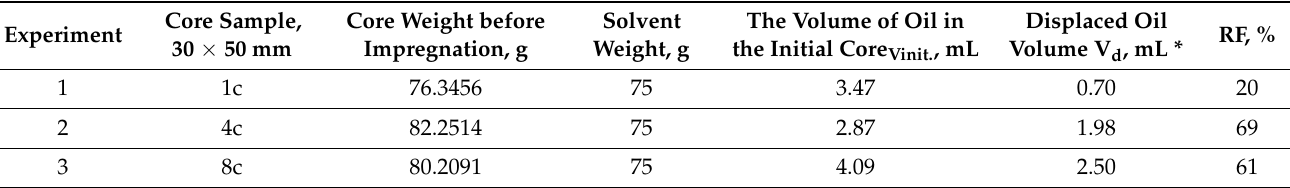
Table 8. The main parameters for conducting soaking experiments.